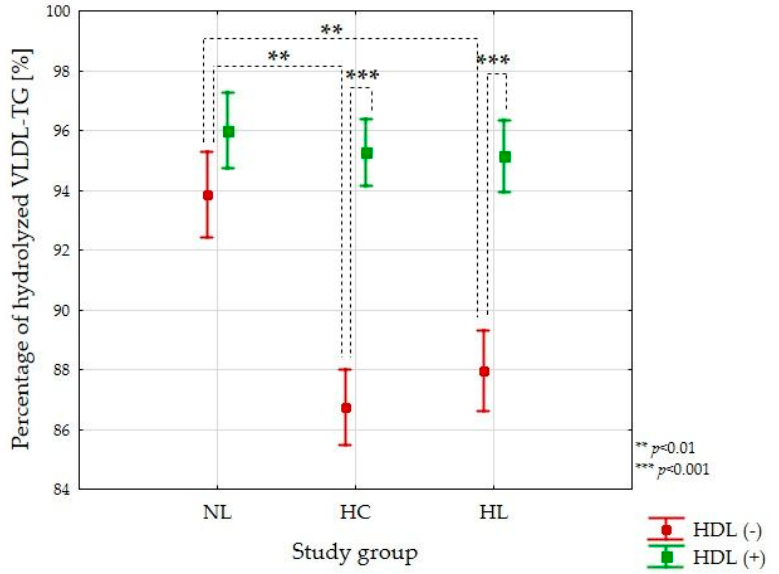
Figure 2. Percentage of VLDL-TG hydrolyzed during LPL-mediated lipolysis in the absence and presence of HDL obtained for normolipidemic (NL, n = 12), hypercholesterolemic (HC, n = 15), and hypelipidemic (HL, n = 13) groups. Data are presented as mean ± SE.